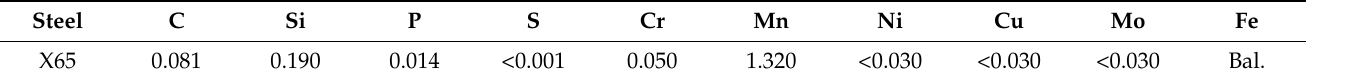
Table 1. Chemical compositions of API X65 steel